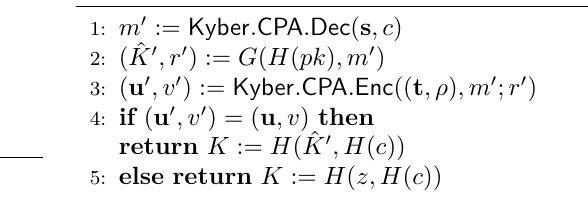
Algorithm 6 Kyber.Encaps(pk)